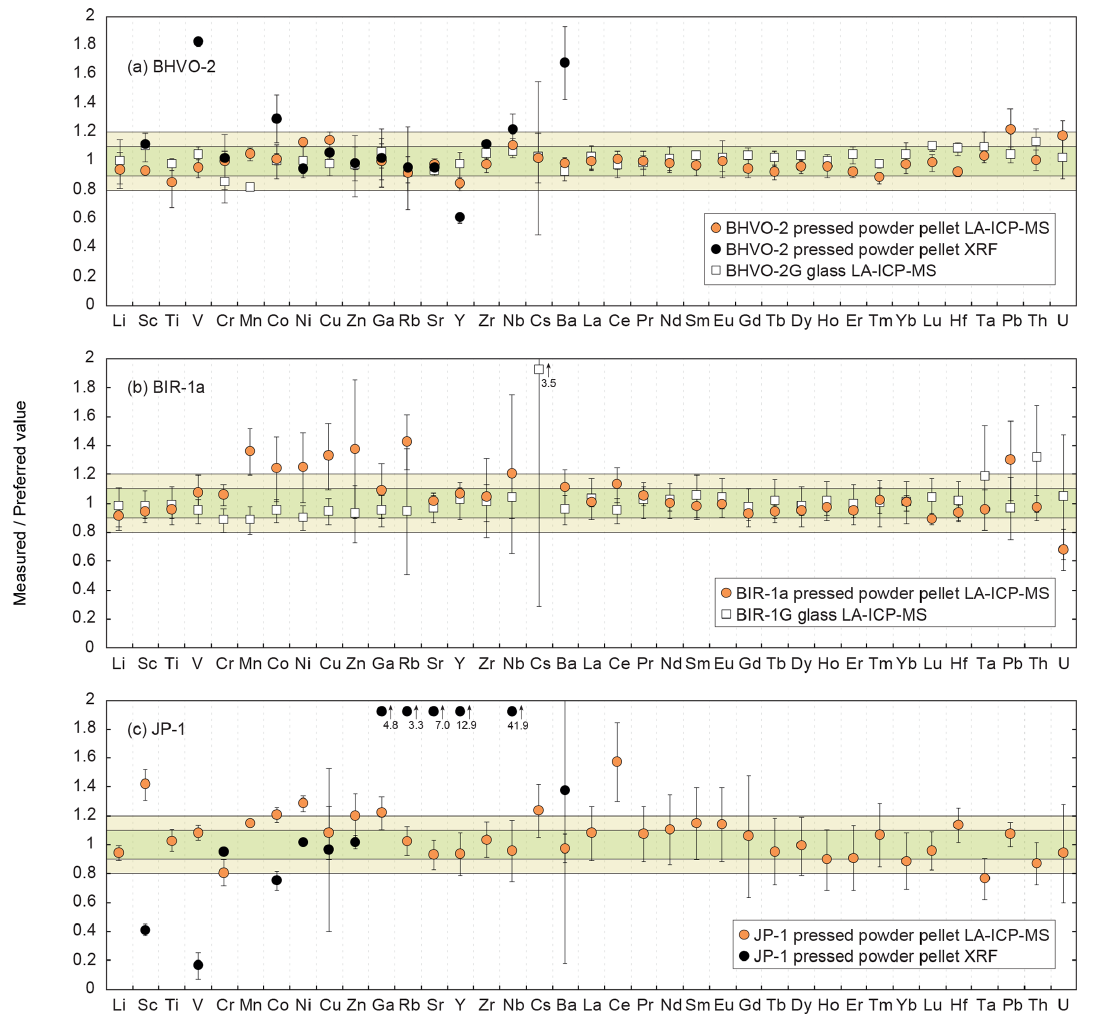
Figure 3. Plots of the results obtained using the LA-ICP-MS dry method developed on-board the D/V Chikyu on pressed powder pellets and glass normalized to preferred values for the standard materials (a) BHVO-2 ( n = 7) and BHVO-2G ( n = 4), (b) BIR-1a ( n = 5) and BIR-1G ( n = 17), and (c) JP-1 ( n = 10). Data obtained by XRF (D/V Chikyu ) on pressed powder pellets are shown for BHVO-2 and JP- 1. Error bars represent the standard deviation, reflecting the intermediate precision (or repeatability) of the averaged composition of the multiple n measurements. The horizontal green and light green fields indicate the 10% and 20% δ PV, respectively. Preferred values are from Jochum et al. (2005) for BHVO-2G and BIR-1G, from Barrat et al. (2012) for BHVO-2, from GeoReM (http://georem.mpch-mainz.gwdg.de, 12 July 2018) for BIR-1a, and from Barrat et al. (2008) (Ti, V, Sr, Zr, Hf), Makishima and Nakamura (2006) (Tm), and Rospabé et al. (2018a) (all other elements) for